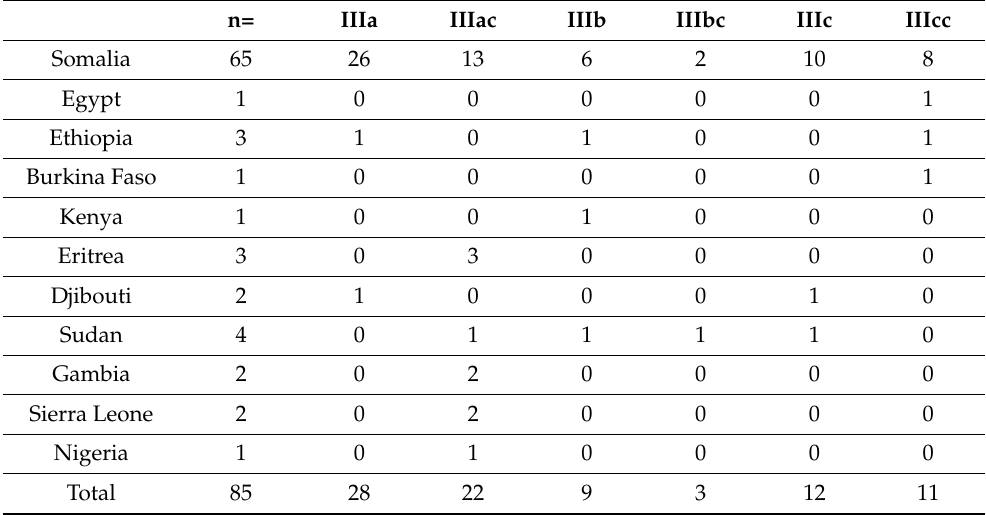
Table 1. Number of patients with Type III mutilation according to our new proposal for a modified classification of Type III Female Genital Mutilation.